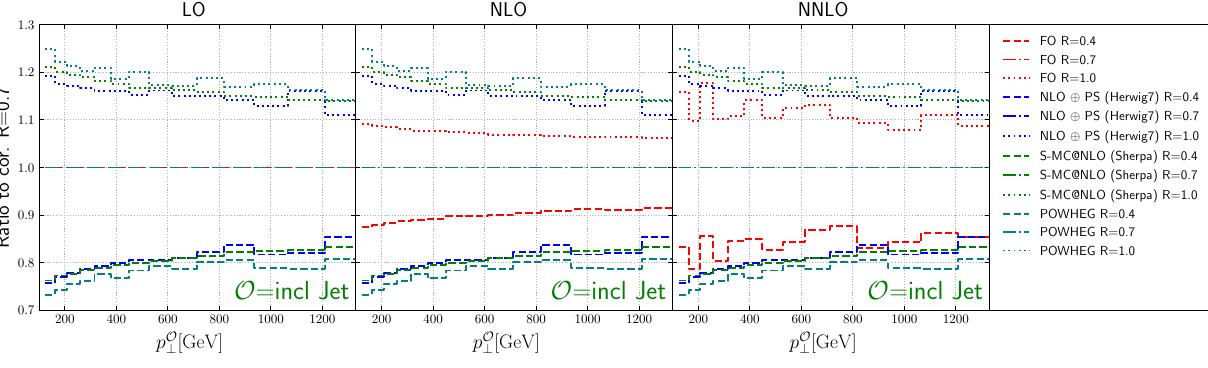
Fig. 13 The ratio of the inclusive jet p T cross section for specific jet sizes, scaled to the cross section for each prediction for a jet size of R = 0 .